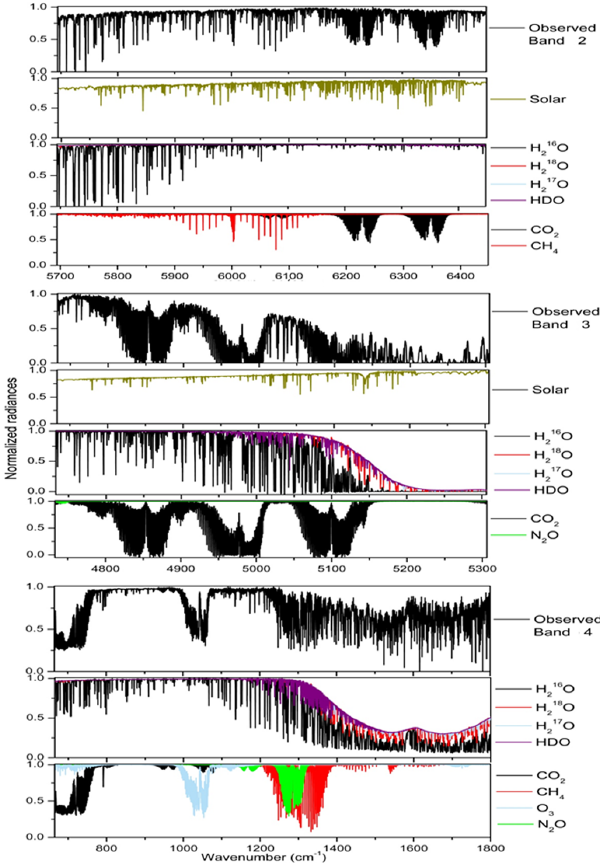
Fig. 1. Example of observed TANSO-FTS spectrum in normalized radiances, simulated solar contribution and individual major molec- ular absorbers. Each band is calculated from our line-by-line for- ward model on US standard profiles with nadir viewing angle and solar zenith angle of 30 ◦